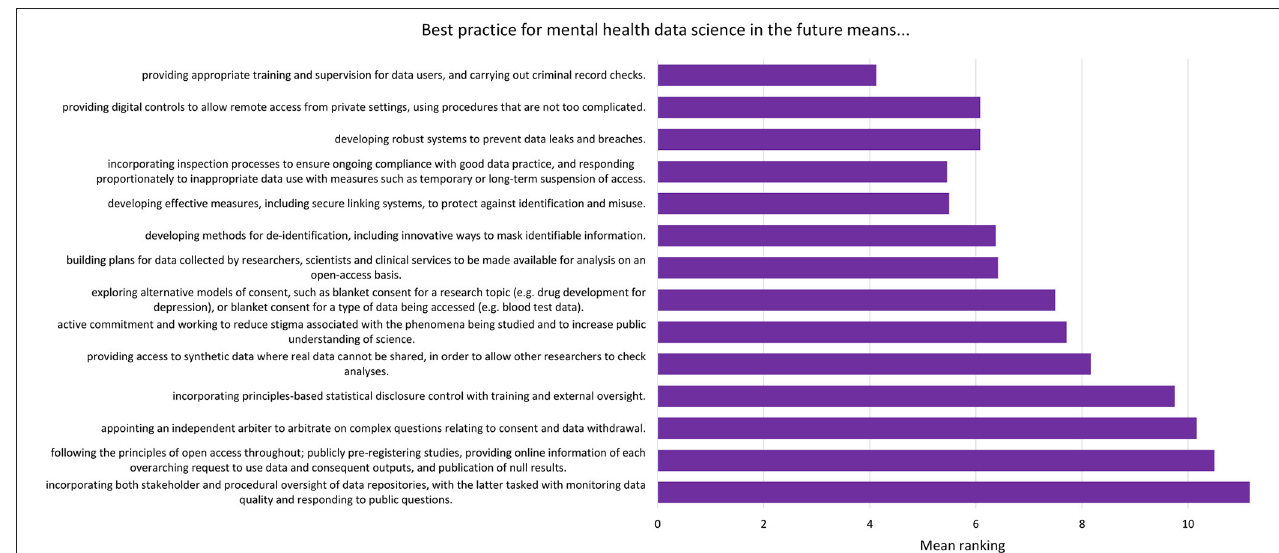
FIGURE 3 | Mean ranking of statements in the future best practice checklist during Phase 2, ordered by median ranking. Lower scores (at the top of the figure) indicate higher importance (number of participants = 24).